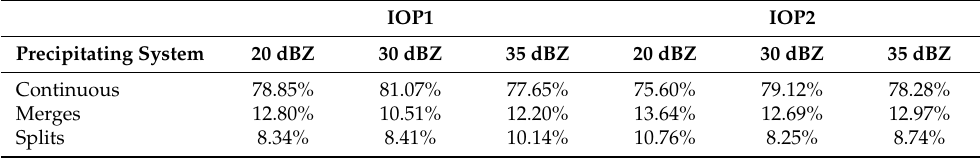
Table 3. Occurrence of the precipitating system classes for each IOP and threshold.